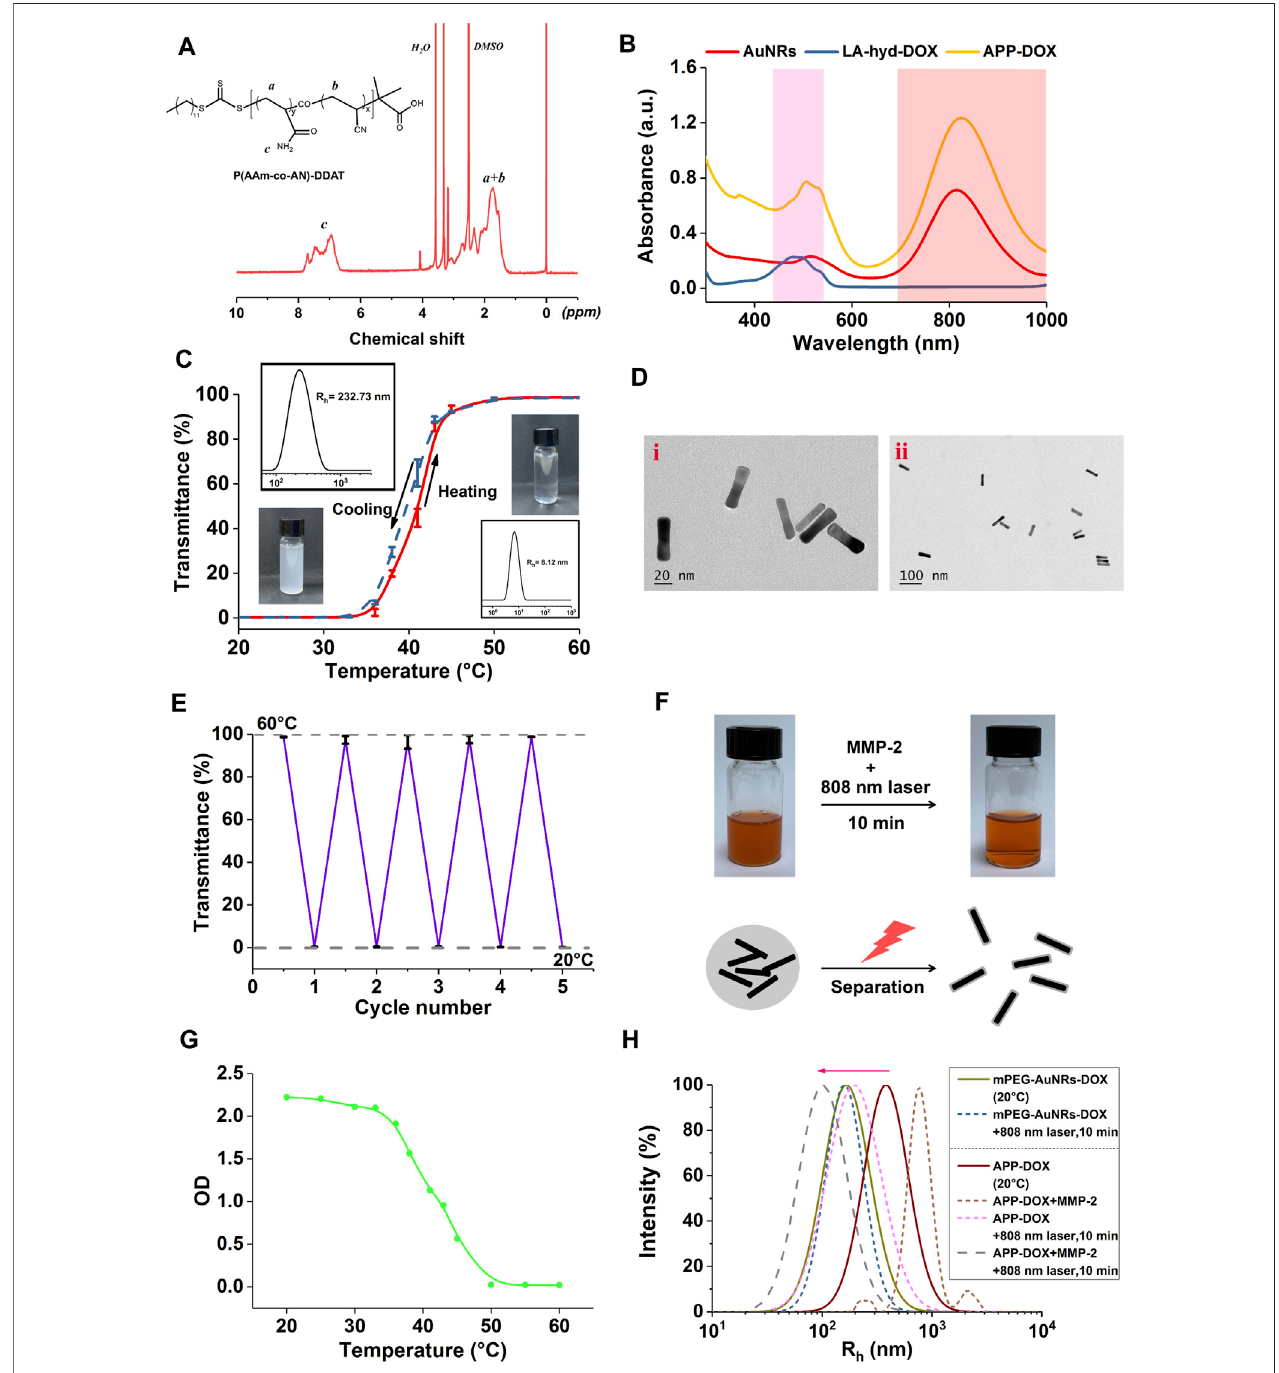
FIGURE1| 1 H-NMRspectraofP(AAm-co-AN)-DDAT (A) .UV-VisabsorptionspectraofAuNRs,LA-hyd-DOX,andAPP-DOX (B) .Lighttransmittance-temperature curve, particle size distribution, and photographs of the self-assembled vesicles of the P(AAm-co-AN)-DDAT (C) . TEM images of AuNRs and APP-DOX (D) . Light transmittancecurveoftheself-assembledvesiclesoftheP(AAm-co-AN)-DDATcopolymerunderalternatecyclesof20and60 ° C (E) .Photographsandmicromechanism diagram of the AuNR-DOX turbidity change under 808 nm laser irradiation for 10 min (F) . Curve of the change in the absorbance (optical density value) of AuNR- DOXduringtheheatingprocessfrom20to60 ° C (G) .ParticlesizedistributioncurvesofmPEG-AuNRs-DOX,APP-DOX,andAPP-DOXco-incubatedwithMMP-2before and after 808 nm laser irradiation (H) .